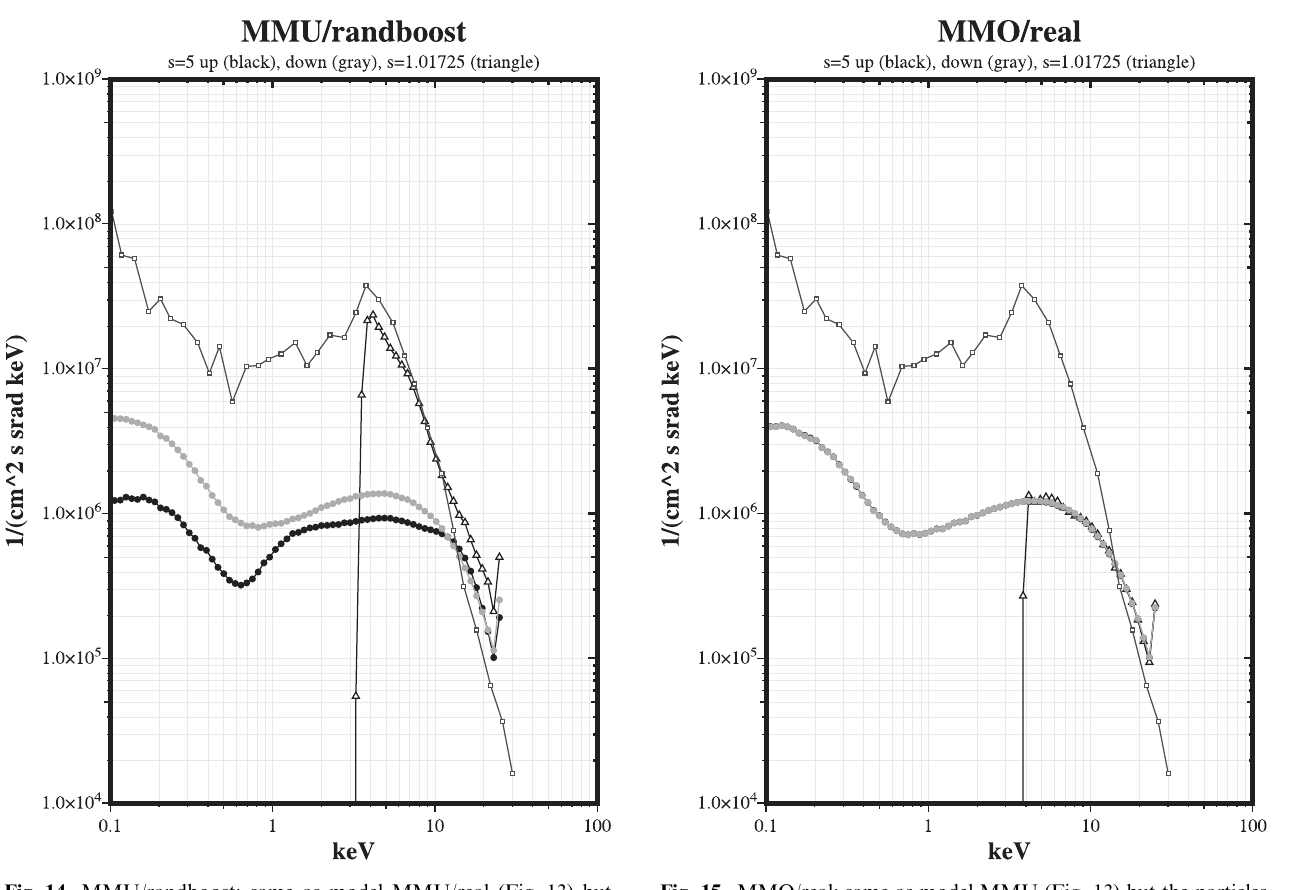
Fig. 14. MMU/randboost: same as model MMU/real (Fig. 13) but with random boosts added. The agreement is pretty good